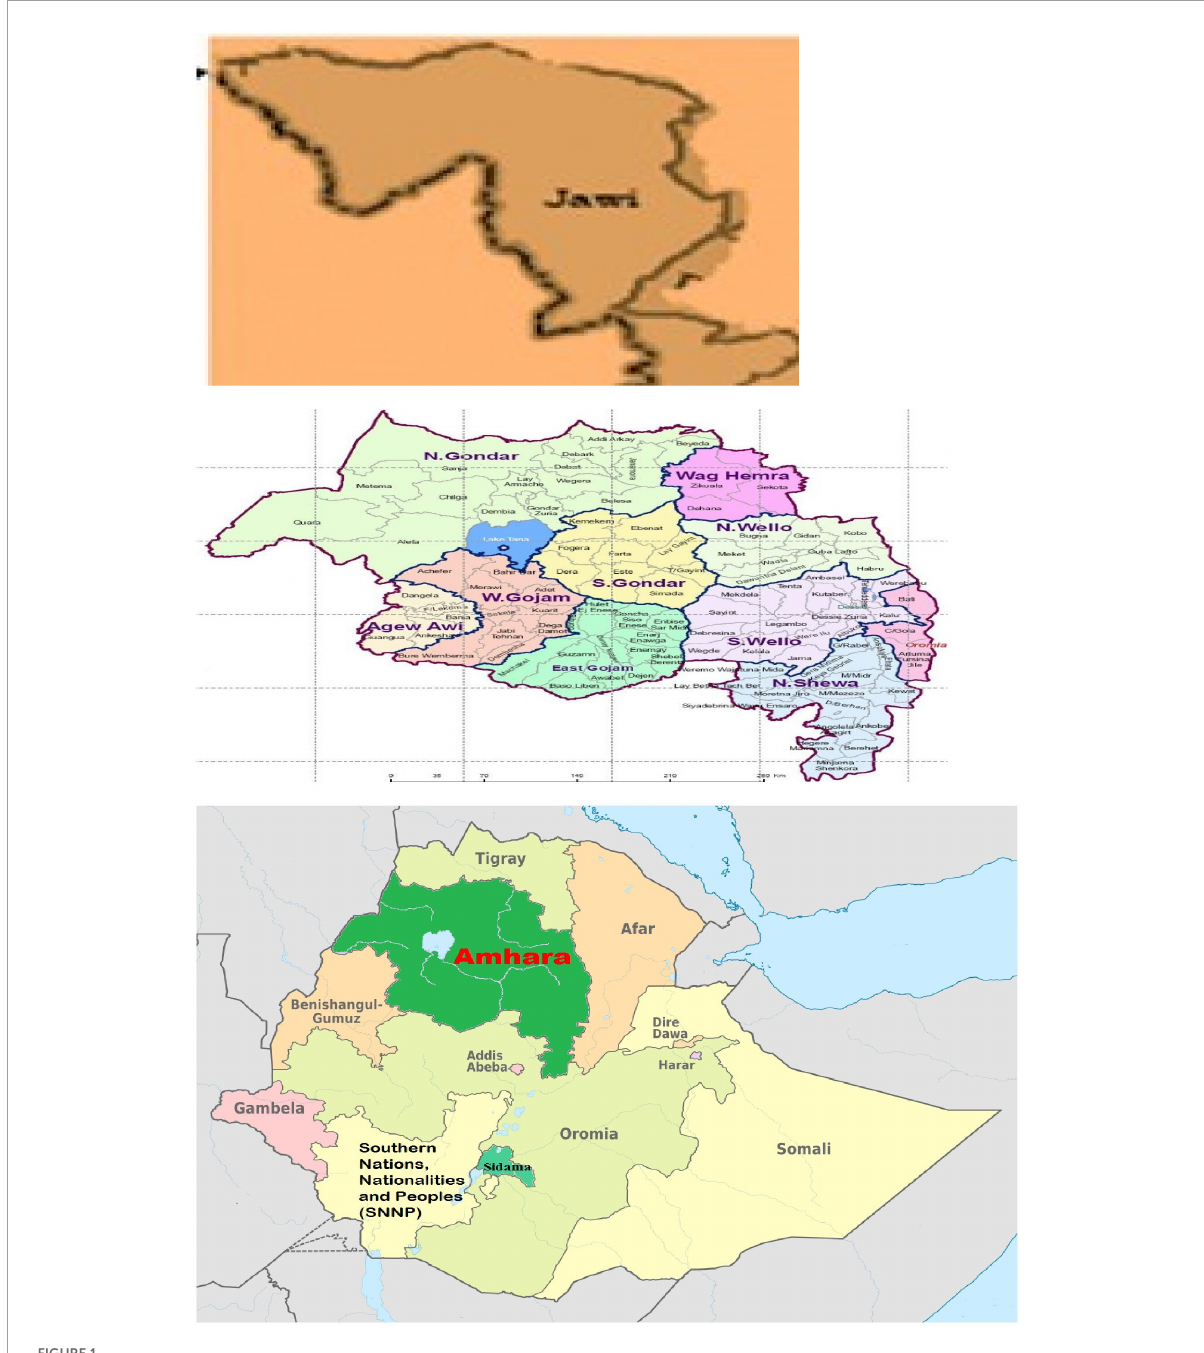
FIGURE1 Map showing Jawi District, Awi Zone, Ethiopia.